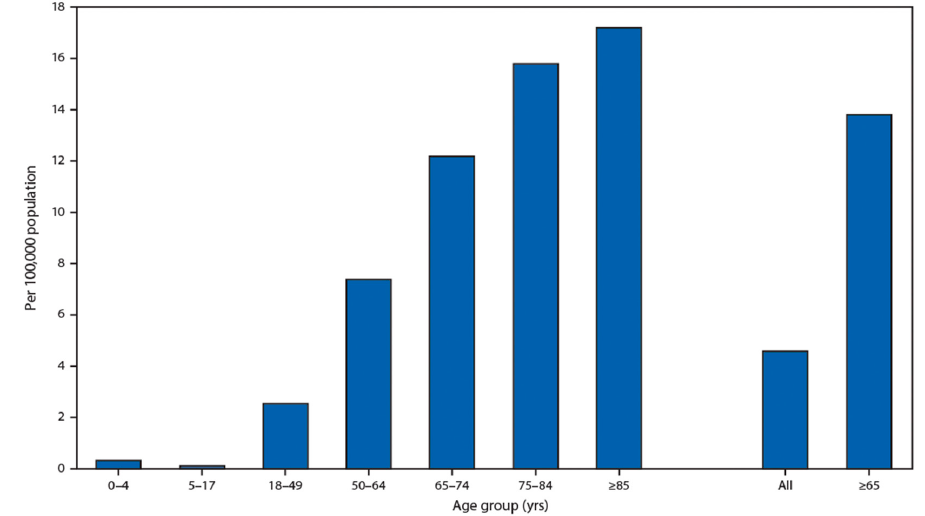
Figure 3. Coronavirus disease 2019 (COVID-19)-associated hospitalization rates, by age group,